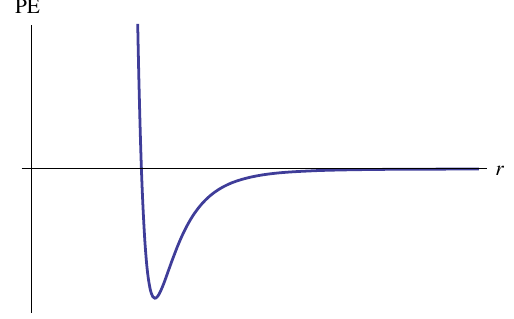
FIG. 1. The Lennard-Jones potential, approximating the inter- action between two